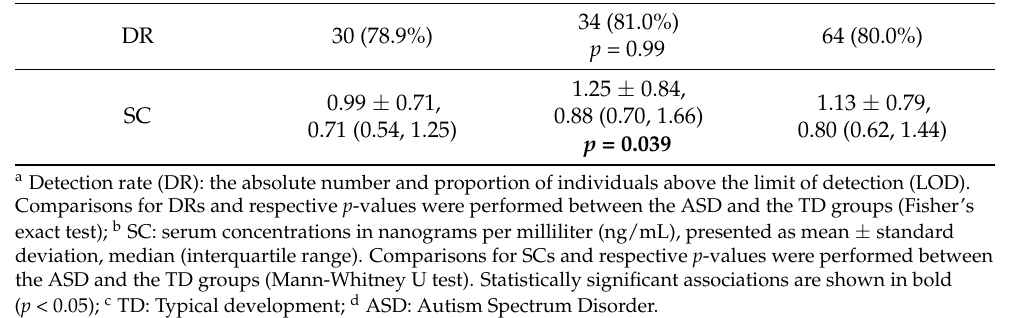
Table 2. Detection rates (DRs) a and serum concentrations (SCs) b of HMGB1 in the study population. TD